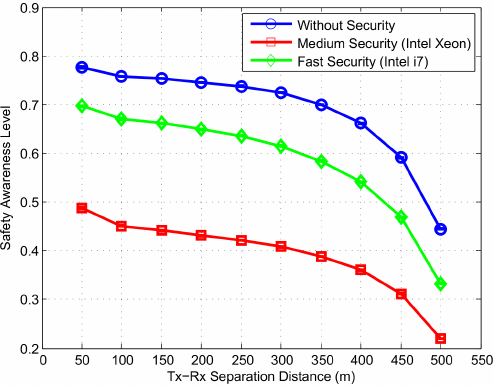
Figure 19. Normalized Weighted Error based Safety Awareness Level metric ( µ ˆ SAL ) at different levels of